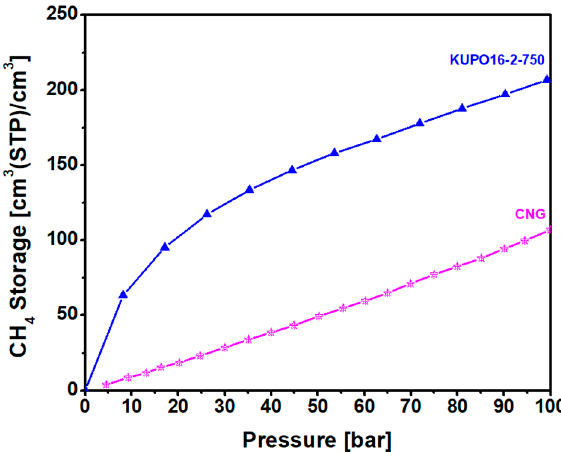
Figure 9. Methane storage capacity at 298 K of KUPO16-2-750 (blue triangles) compared to compressed methane gas (CG, pink stars).